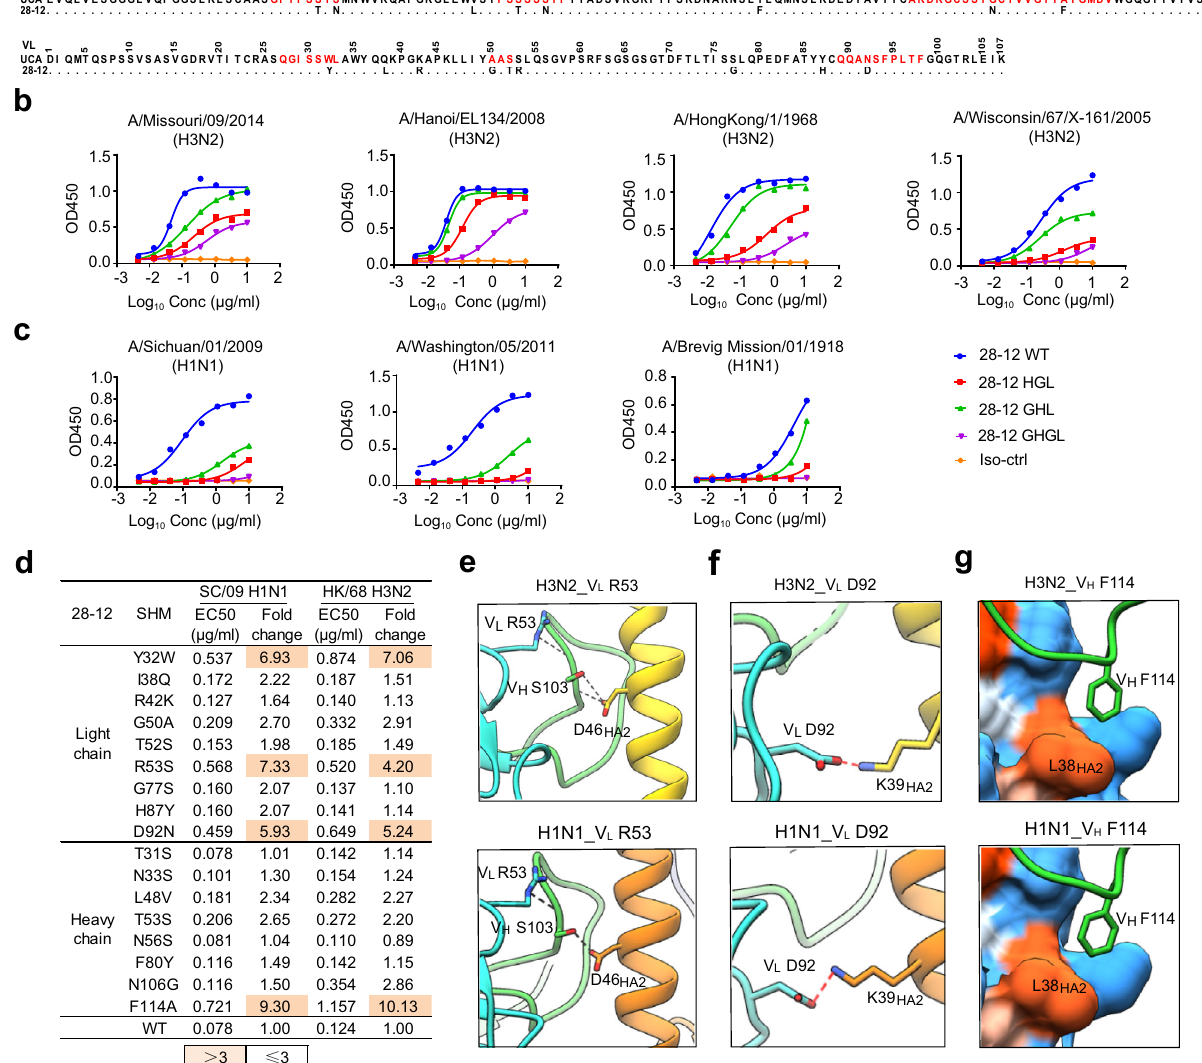
Fig. 6 Somatic hypermutations of 28-12. a Sequence alignment of 28-12 and its UCA. Dots indicate identical residues. CDR regions according to IMGT are shown in red. b , c The reactivity of 28-12 germline variants to H3N2 ( b ) and H1N1 HAs ( c ). GHGL, V H germline paired with V L germline. HGL, 28-12 V H paired with its V L germline. GHL, 28-12 V L paired with its V H germline. d Heatmap showing the EC50 values of 28-12 variants with single somatic mutations to H3N2 and H1N1 HAs. e For both 28-12-H3 and 28-12-H1 complexes, V L R53 forms hydrogen bonds with the main chain of V H S103 in HCDR3, which also contacts the residue D46 HA2 through hydrogen bonds. f For both 28-12-H3 and 28-12-H1 complexes, V L D92 of 28-12 forms salt bridges with K39 HA2 of helix A. g V H F114 inserts into a hydrophobic groove formed by L38 HA2 of both H3N2 and H1N1 HAs. The colors of HA1 and HA2 and the heavy chain and light chain of 28-12 are shown as in Fig. 4. The salt bridge and hydrogen bond are shown as red and black dashed lines, respectively. Data are presented as mean values of duplicates ( b , c ). Representative data are shown from two independent experiments ( b , c